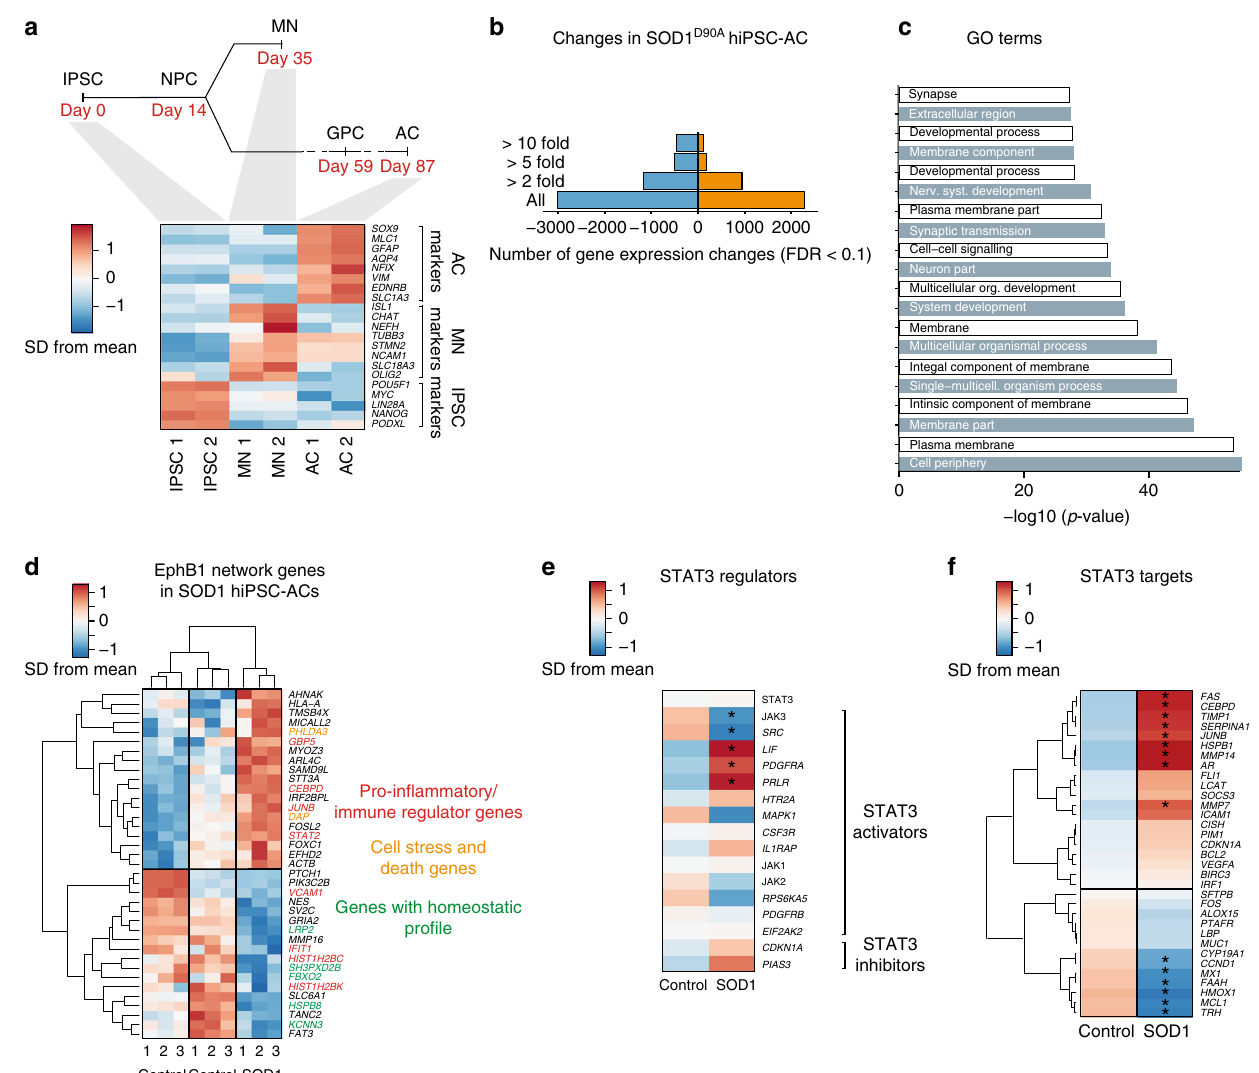
Fig. 6 Transcriptome-wide analysis in enriched human SOD1 D90A ALS patient-derived iPSC-astrocytes. a Heatmaps indicating exclusive enrichment of astrocyte (AC)-speci fi c genes vs. hiPSC-speci fi c and motor neuron-speci fi c transcripts. b The number of gene expression changes (FDR ≤ 0.1) vs. controls ( n = 3 independently converted astrocyte cultures from hiPSCs; see Supplementary Table 1 for information on patient lines). c GO term analysis of genes signi fi cantly upregulated when compared to controls using the DAVID interface. d Most signi fi cantly downregulated or induced transcripts in control or SOD1 hiPSC-astrocytes, which are overlapping with EphB1-induced mouse astrocyte genes. Known common pro-in fl ammatory/immune-regulator, cell stress/death genes and transcripts with homeostatic pro fi le are labelled in red, orange and green, respectively. e , f Heatmaps demonstrating upregulation or downregulation of STAT3 inducers and inhibitors ( e ) and the STAT3 target pro fi le ( f ) in control and SOD1-mutant hiPSC-astrocytes. Stars in e , f indicate signi fi cantly changed genes (FDR ≤ 0.1). For heatmaps gene expression data represent SD from mean of variance stabilised values across